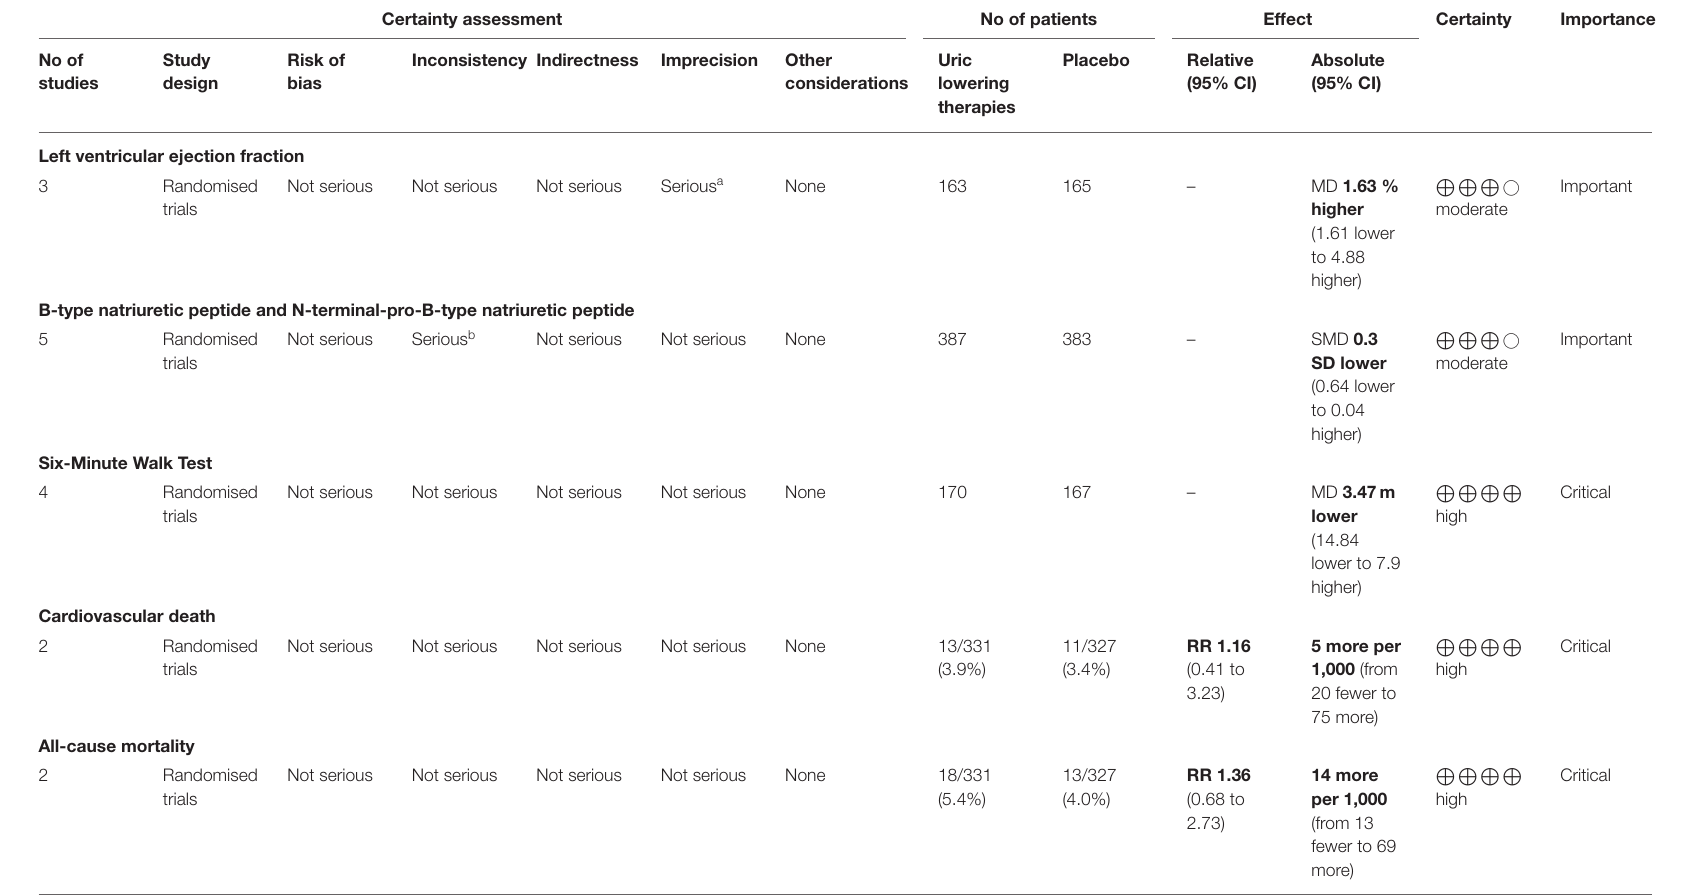
TABLE 2 | GRADE evidence